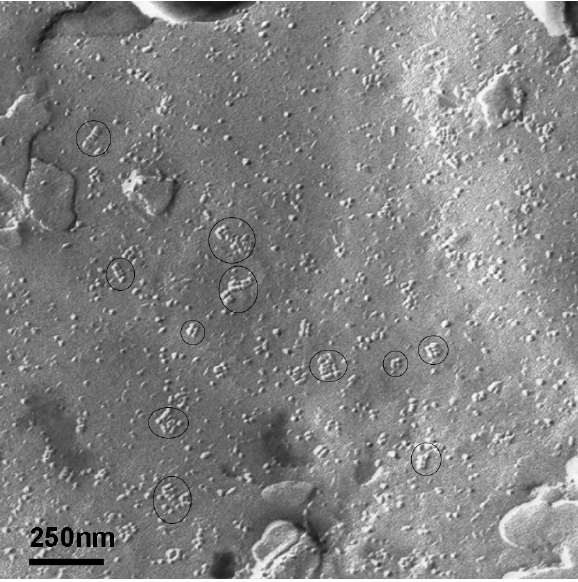
Figure 6. Freeze fracture replica of a healthy murine astrocyte in culture showing OAPs encircled.